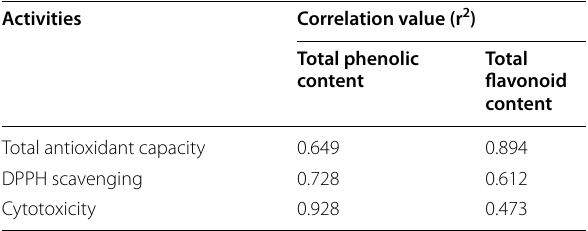
Table 2 Total antioxidant capacity and DPPH scavenging activity of the different fractions of C. asiatica